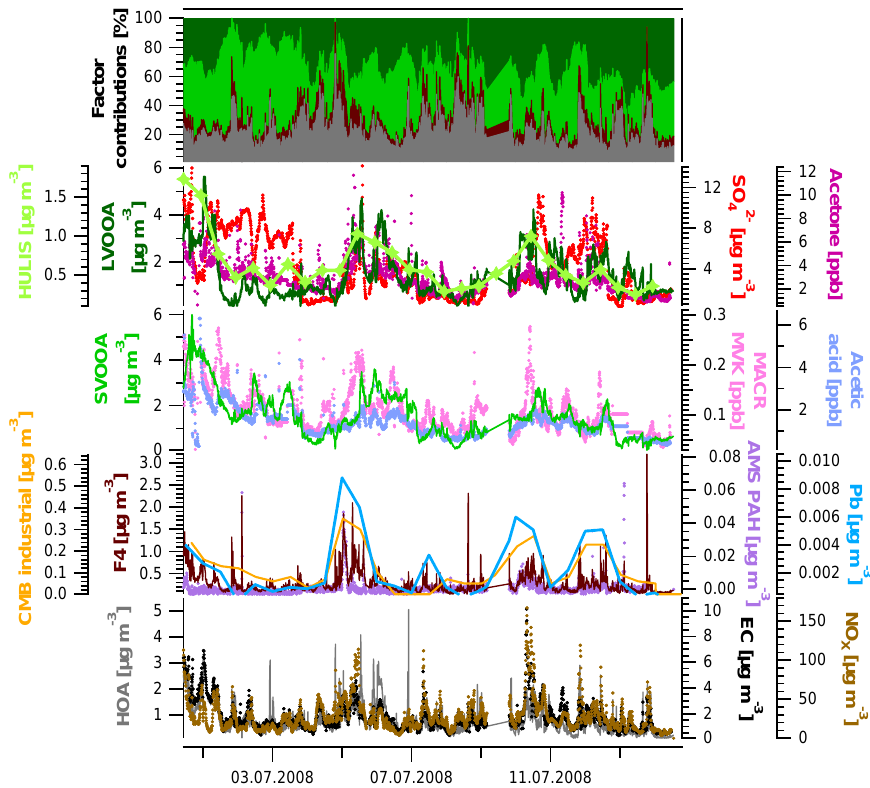
Fig.3: Time series for AMS/PMF2 4-factors solution (FPEAK=0, SEED=0) compared with 1114 Fig. 3. Time series for AMS/PMF2 4-factors solution (FPEAK = 0, SEED = 0) compared with selected tracers NO X and EC for HOA, selected tracers: NO x and EC for HOA, Pb, AMS-PAHs, CMB industrial OA for F4, acetic acid 1115 Pb, AMS-PAHs, CMB industrial OA for F4, acetic acid (PTRMS, m/z 61, C 2 H 5 O + (PTRMS, m/z 61 , C 2 H 5 O 2+ ) and MACR+MVK (PTRMS, m/z 73 , C 4 H 7 O + ) for SVOOA, and 1116 acetone (PTRMS, m/z 59, C 3 H 7 O + ) , HULIS and SO 42- for LVOOA. The upper-panel shows 1117 SVOOA, and acetone (PTRMS, m/z 59, C 3 H 7 O + ) , HULIS and SO 2 −